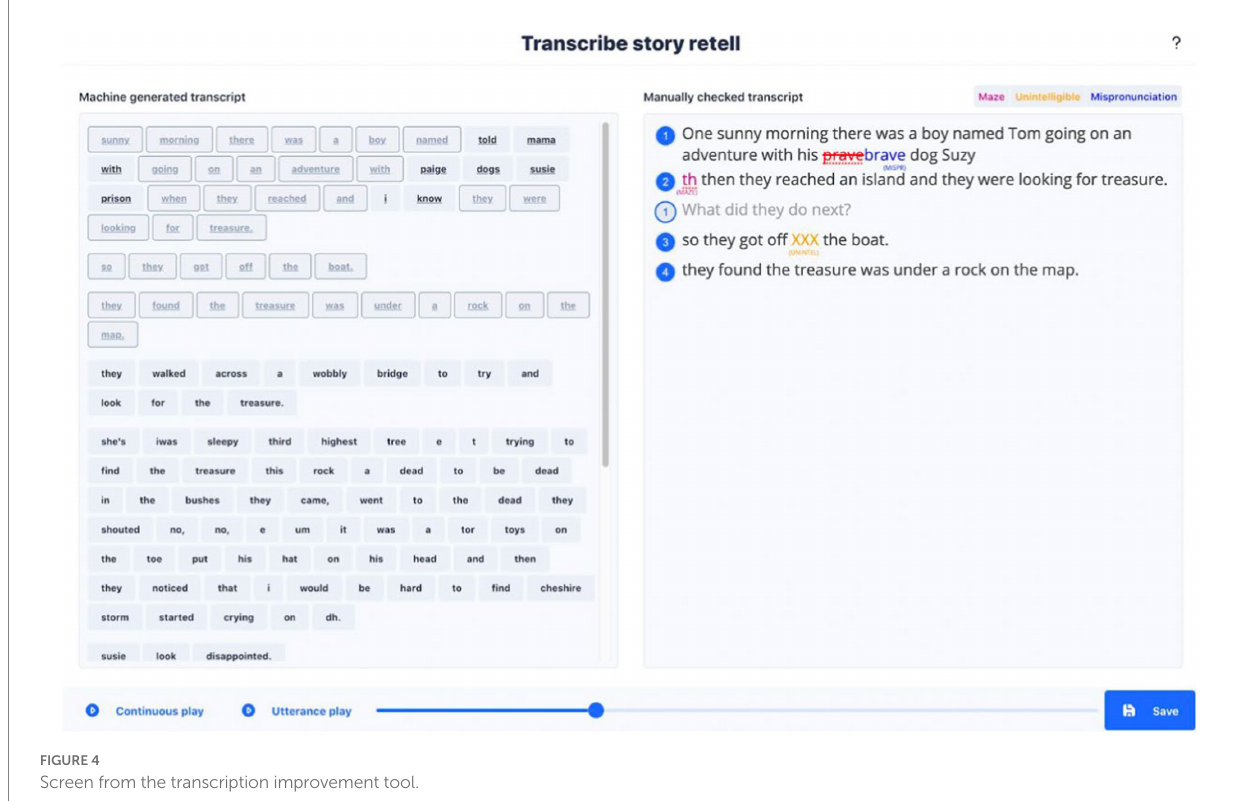
FIGURE 4 Screen from the transcription improvement tool.